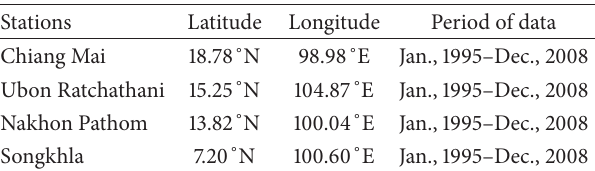
Table 2: Details of the stations and their data.